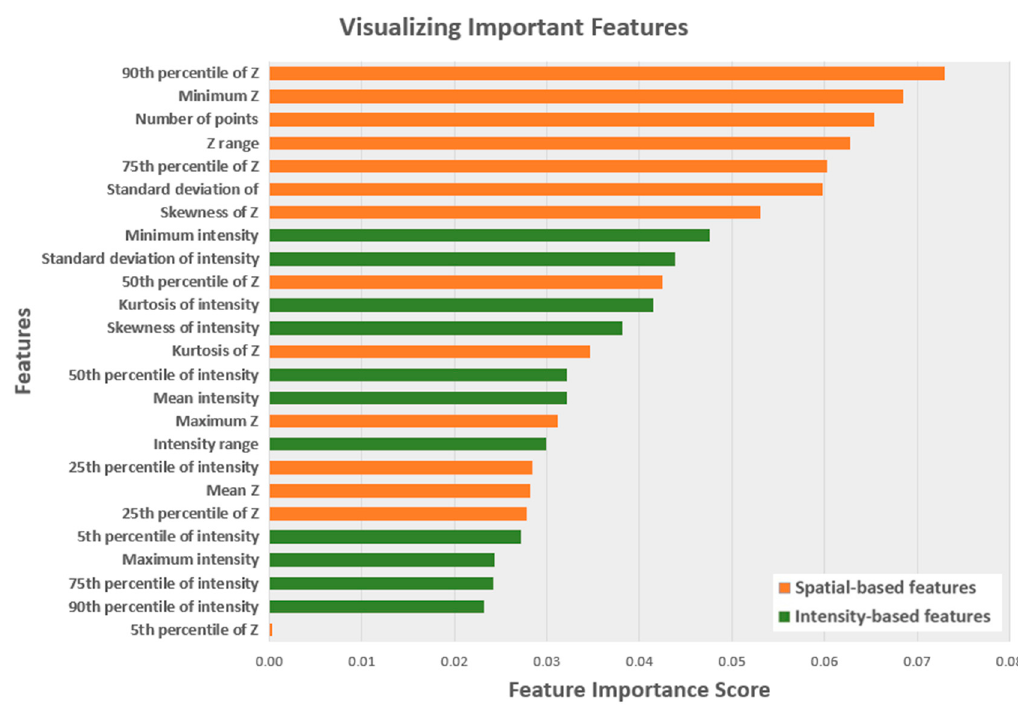
Figure 10. The feature importance scores according to MDG in the RF classification.